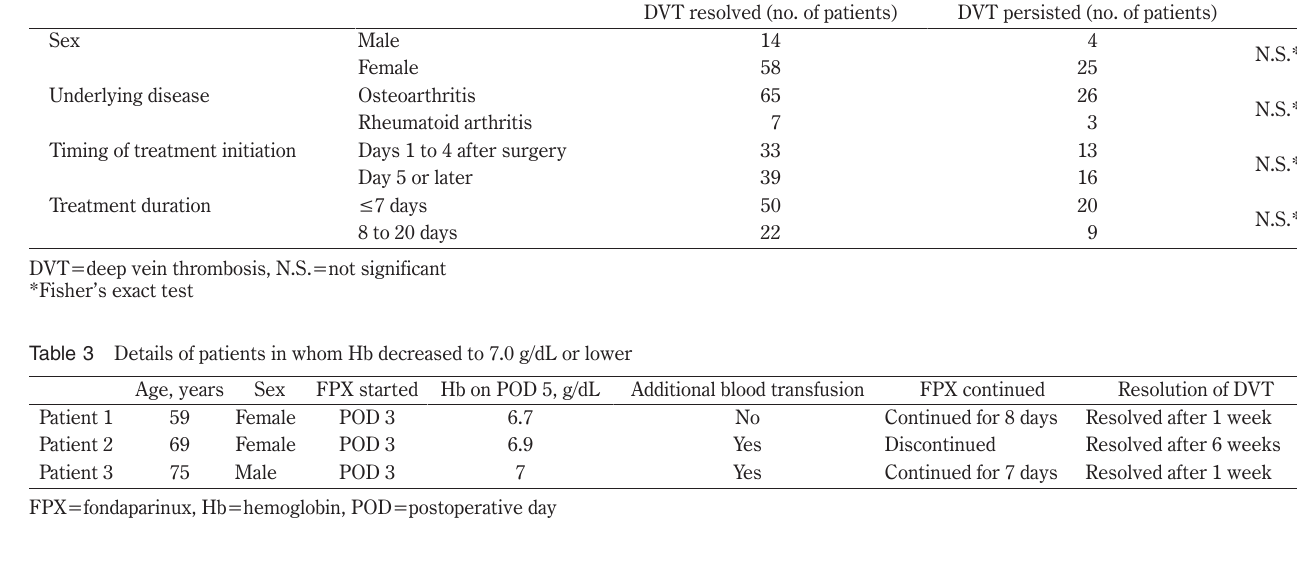
Table 2 Resolution of DVT according to sex, underlying disease, timing of treatment initiation, and treatment duration DVT resolved (no. of